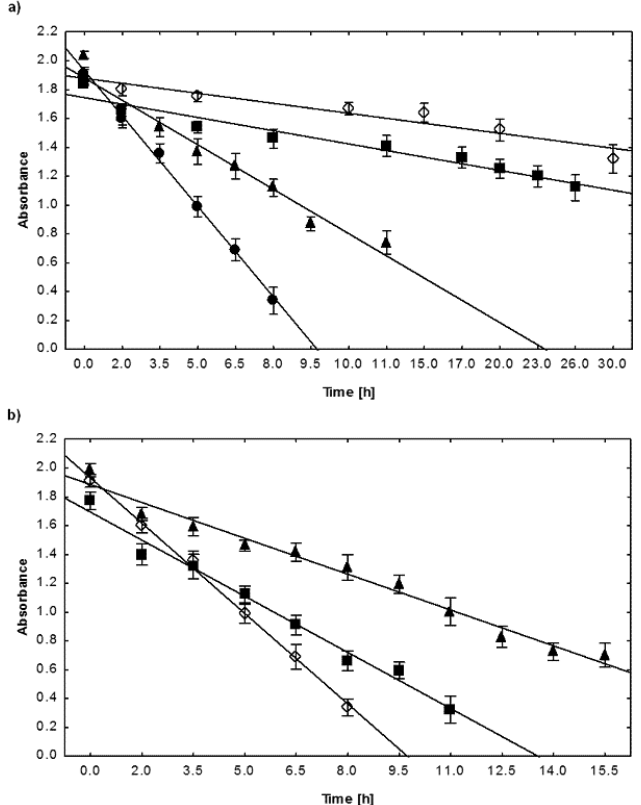
Figure 2. Changes in EHMC absorbance during UV irradiation: a) impact of the presence of H ―▲― EHMC/H